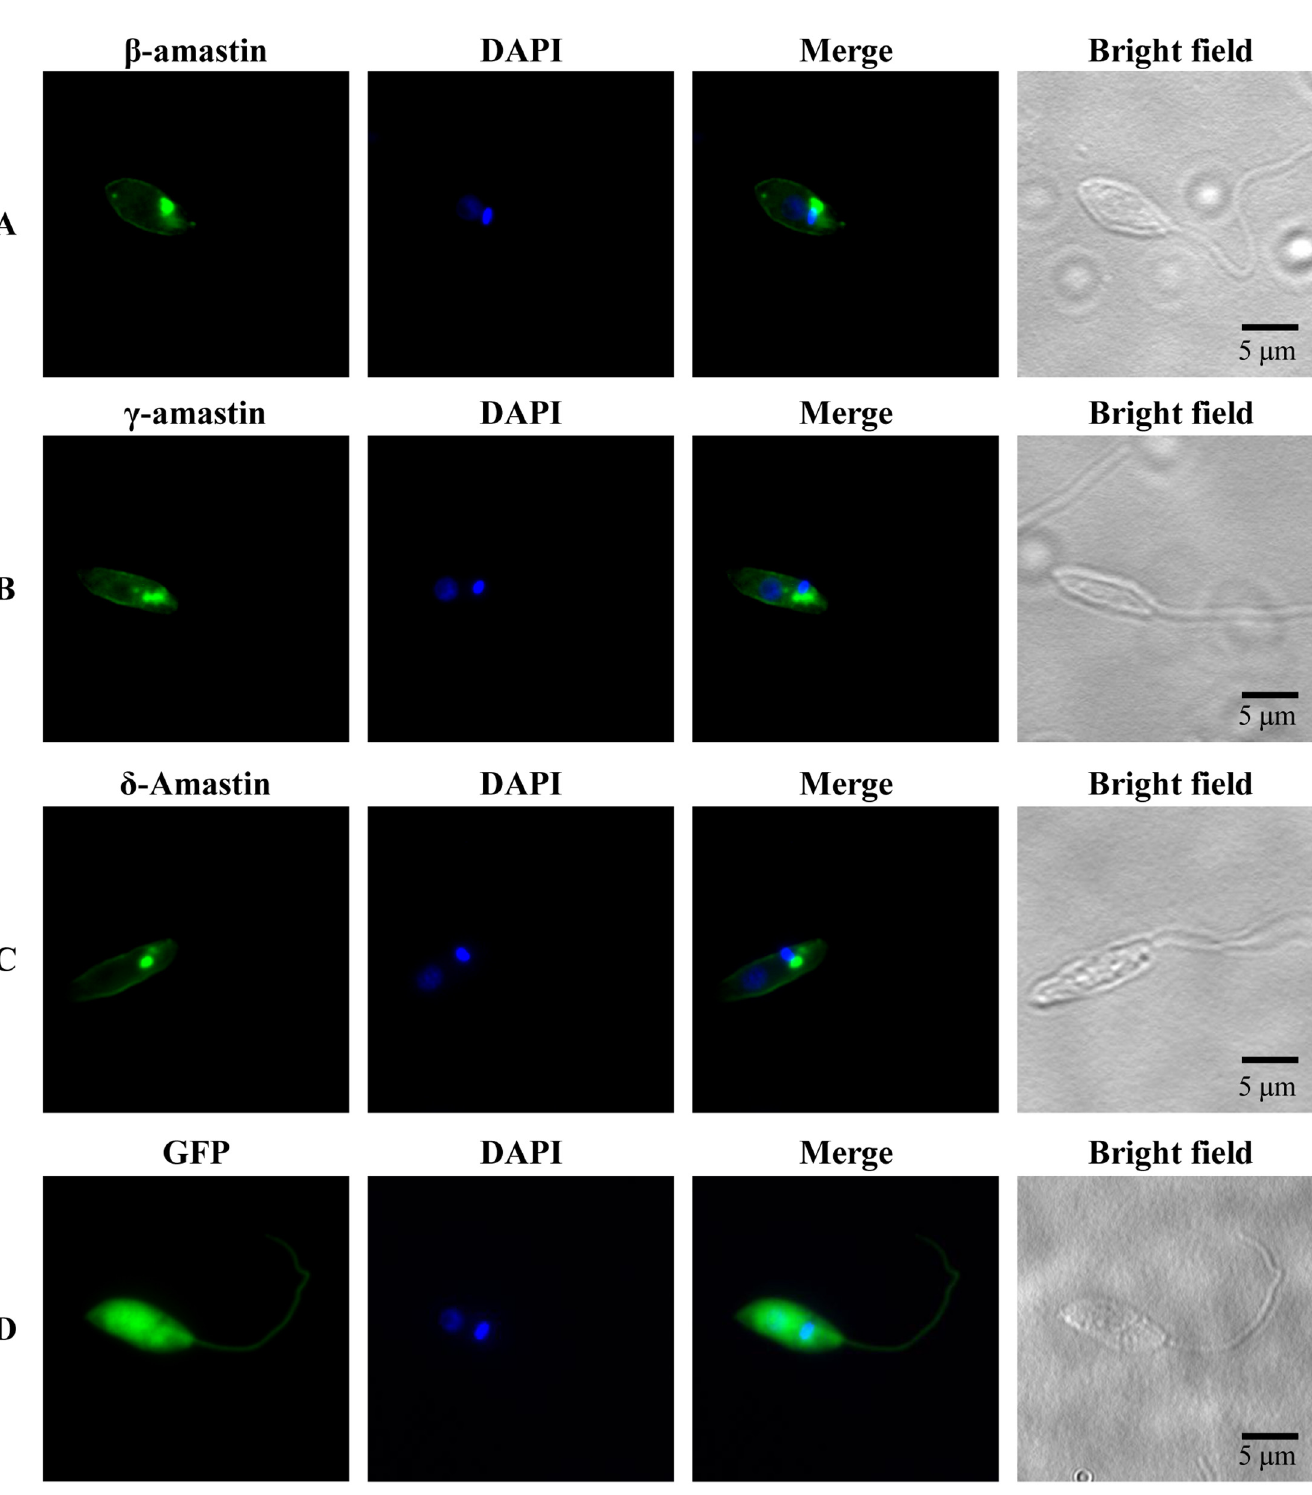
Fig 5. Subcellular localization of distinct amastins in fusion with GFP. Promastigotes were transiently transfected with the plasmids pSP-Ama0980-GFP (A), pSP-Ama1600-GFP (B), pSP-Ama1060-GFP (C) and pSP-nGFP (D) as a control plasmid. Transfected parasites were fixed with 2% paraformaldehyde, stained with DAPI and visualized under a fluorescence microscope. Nuclear and kinetoplast DNA are shown in